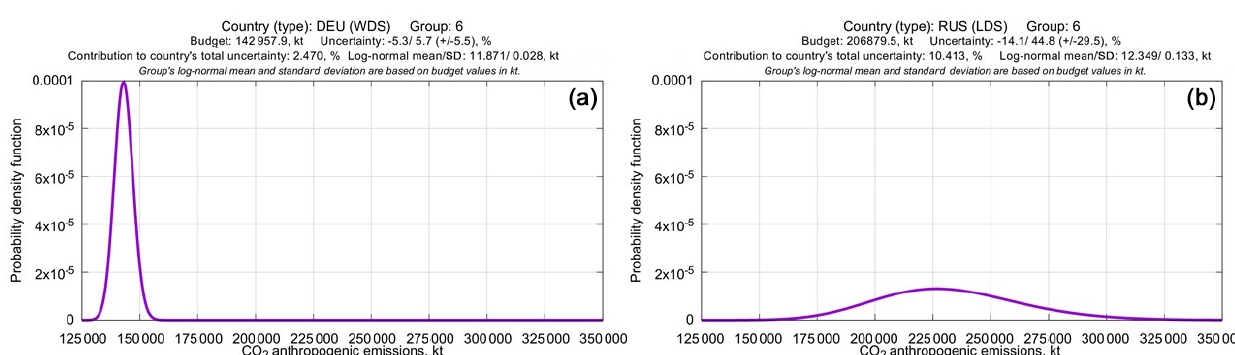
Figure 2. Probability density functions (for Germany a and the Russian Federation b ) based on computed log-normal mean and standard deviation for the TRANSPORT